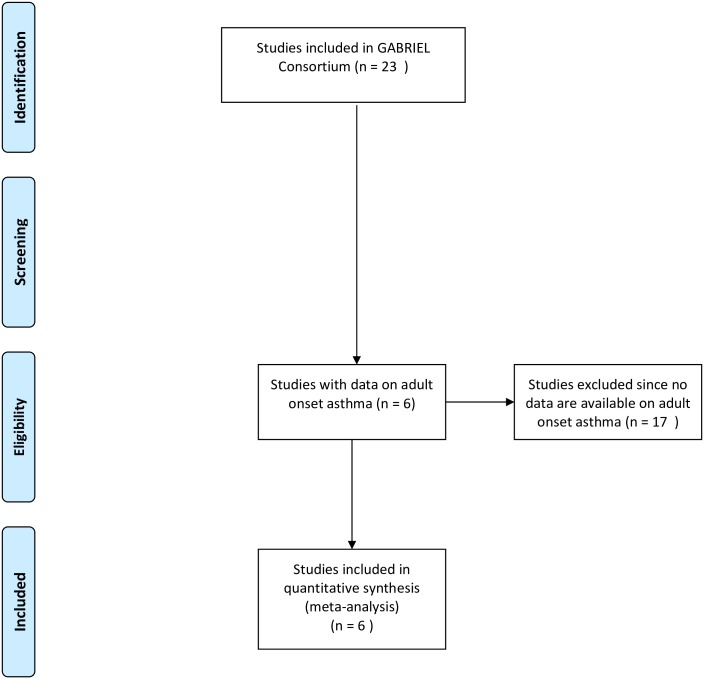
PRISMA flow diagram.